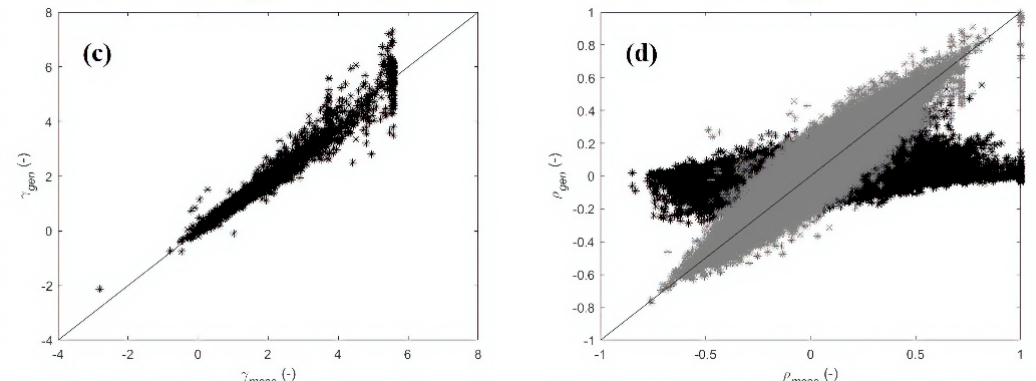
Figure 2. Case study 1 (Application 1)—Comparison between measured and generated hourly demands at single user level: ( a ) mean values µ , ( b ) standard deviation values σ , ( c ) skewness γ , ( d ) rank cross-correlations (black) ρ and ρ − lag 0 (gray).